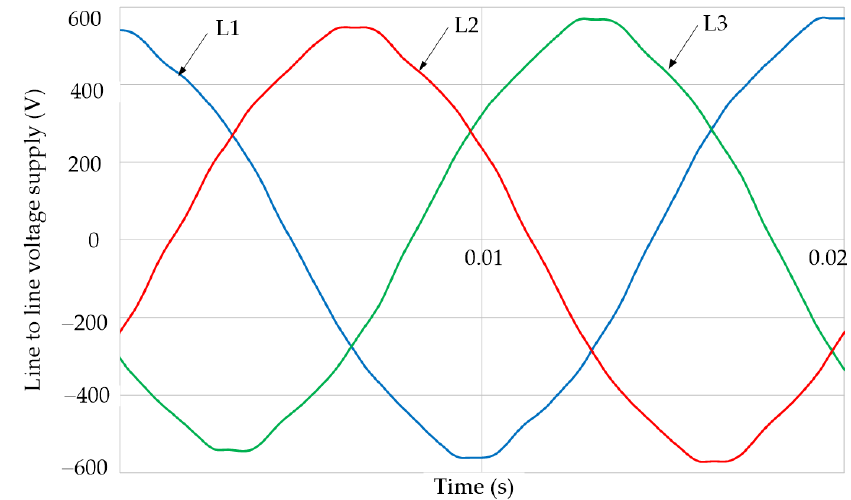
Figure 6. Measured waveforms of line-to-line voltages in the power supply network.